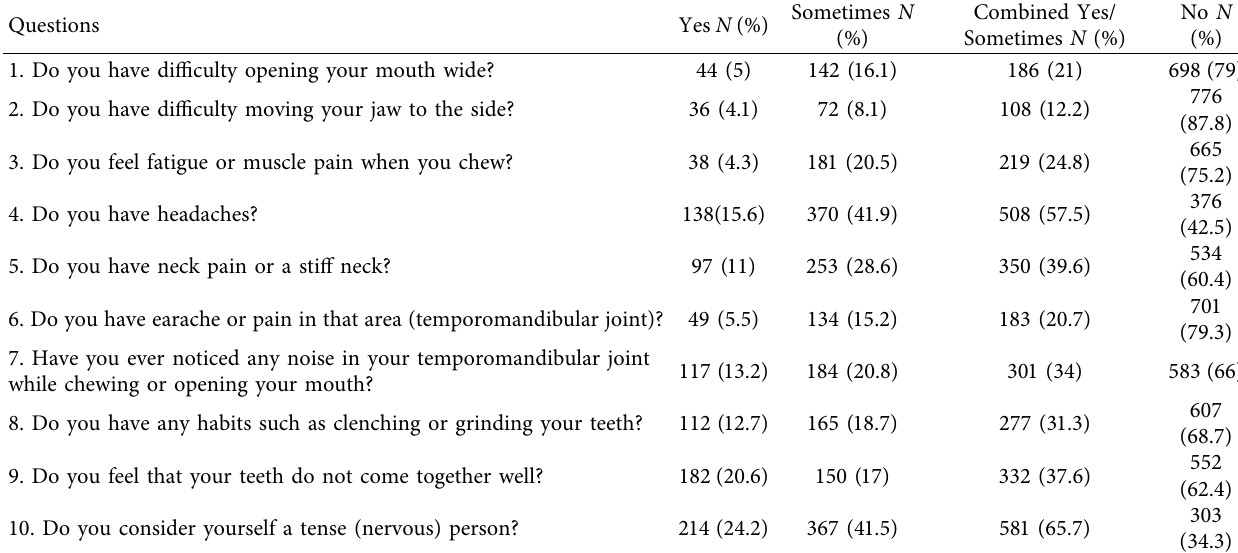
Table 2: Distribution of study participants’ responses to Fonseca’s